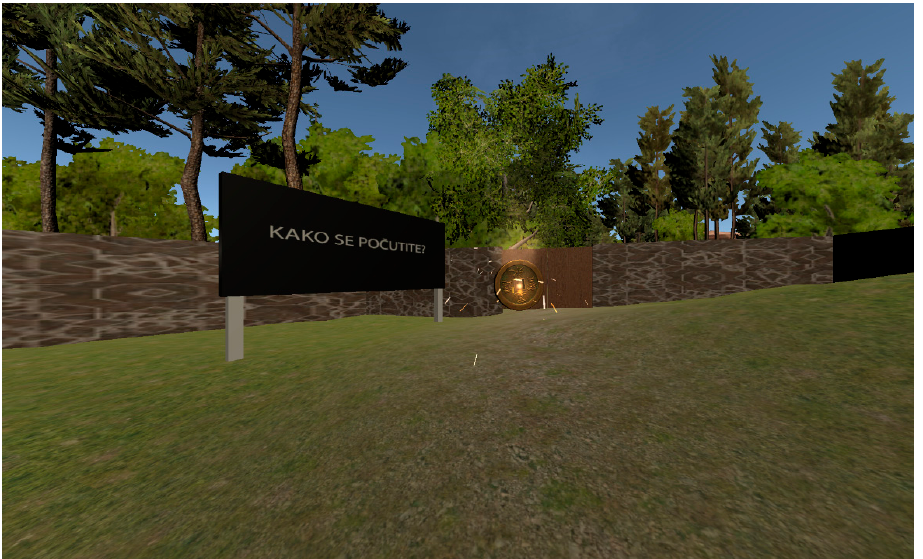
Figure 4. Screenshot from the LA game without rest-frames in front of the table for collecting the Fast Motion Sickness (FMS) score. There are visible doors in the background, which were needed to be opened to continue onto the next